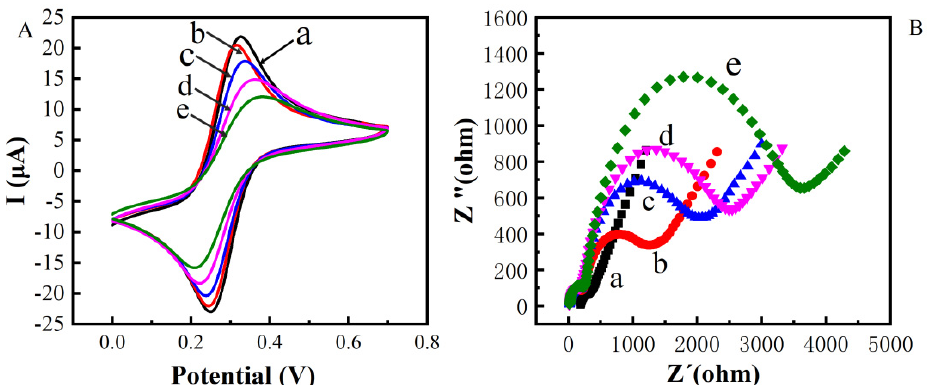
Figure 3. Cyclic voltametric characterization of constructing electrochemical immunosensor ( A ) Elec- trochemical impedance spectroscopy characterization of constructing electrochemical immunosensor ( B ) (a: bare Au; b: bare Au/ZnO; c: bare Au/ZnO/antibody; d: bare Au/ZnO/antibody/BSA; e: bare Au/ZnO/antibody/BSA/TeA). Table 1. Comparison table of characterization results.